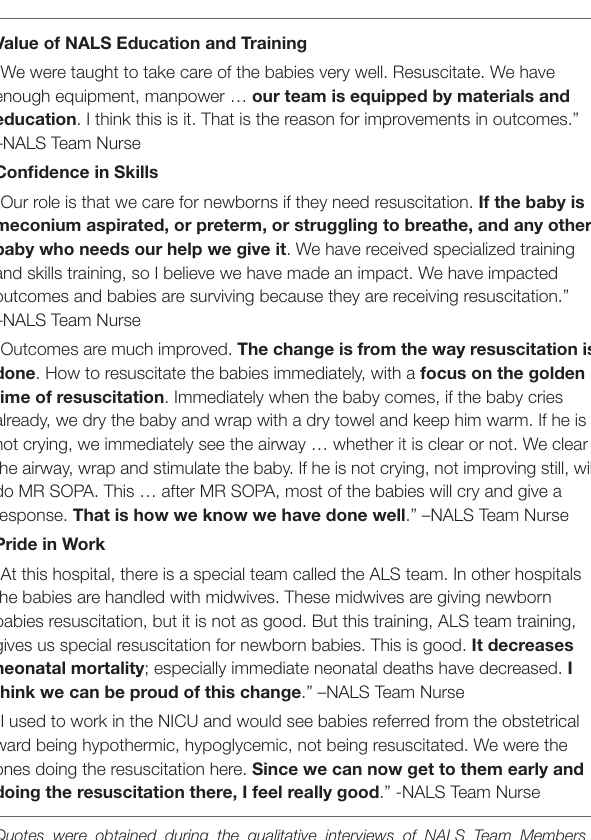
TABLE 6 | Quotes regarding the impact made by the Advanced Life Support (ALS) Team at St. Paul’s Hospital. Major Themes with Representative Quotes from Non-NALS Neonatal Care